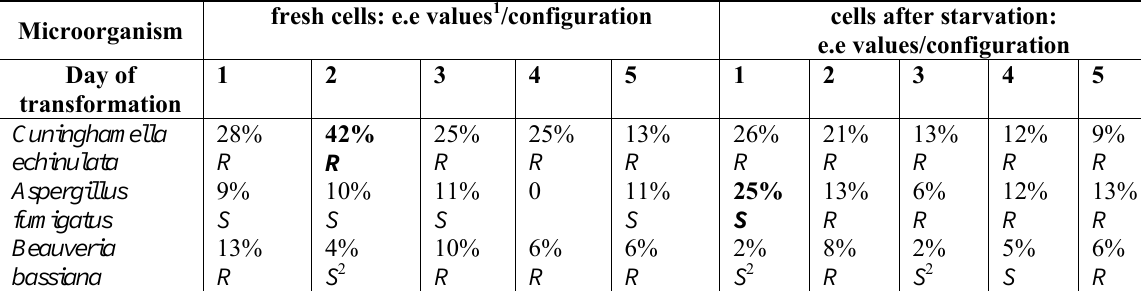
Table 1. Biooxidative resolution of 1-aminoethanephosphonic